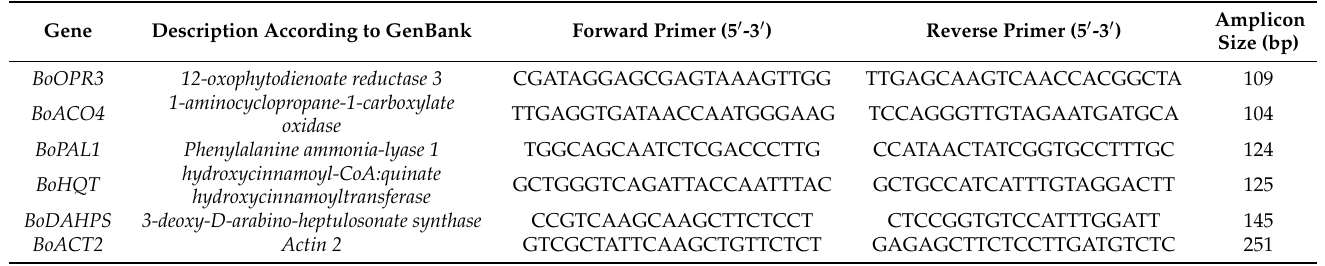
Table 2. Primers used in qRT-PCR to evaluate the expression of genes related to the biosynthesis of stress-signaling molecules, primary metabolites, and phenolic compounds in